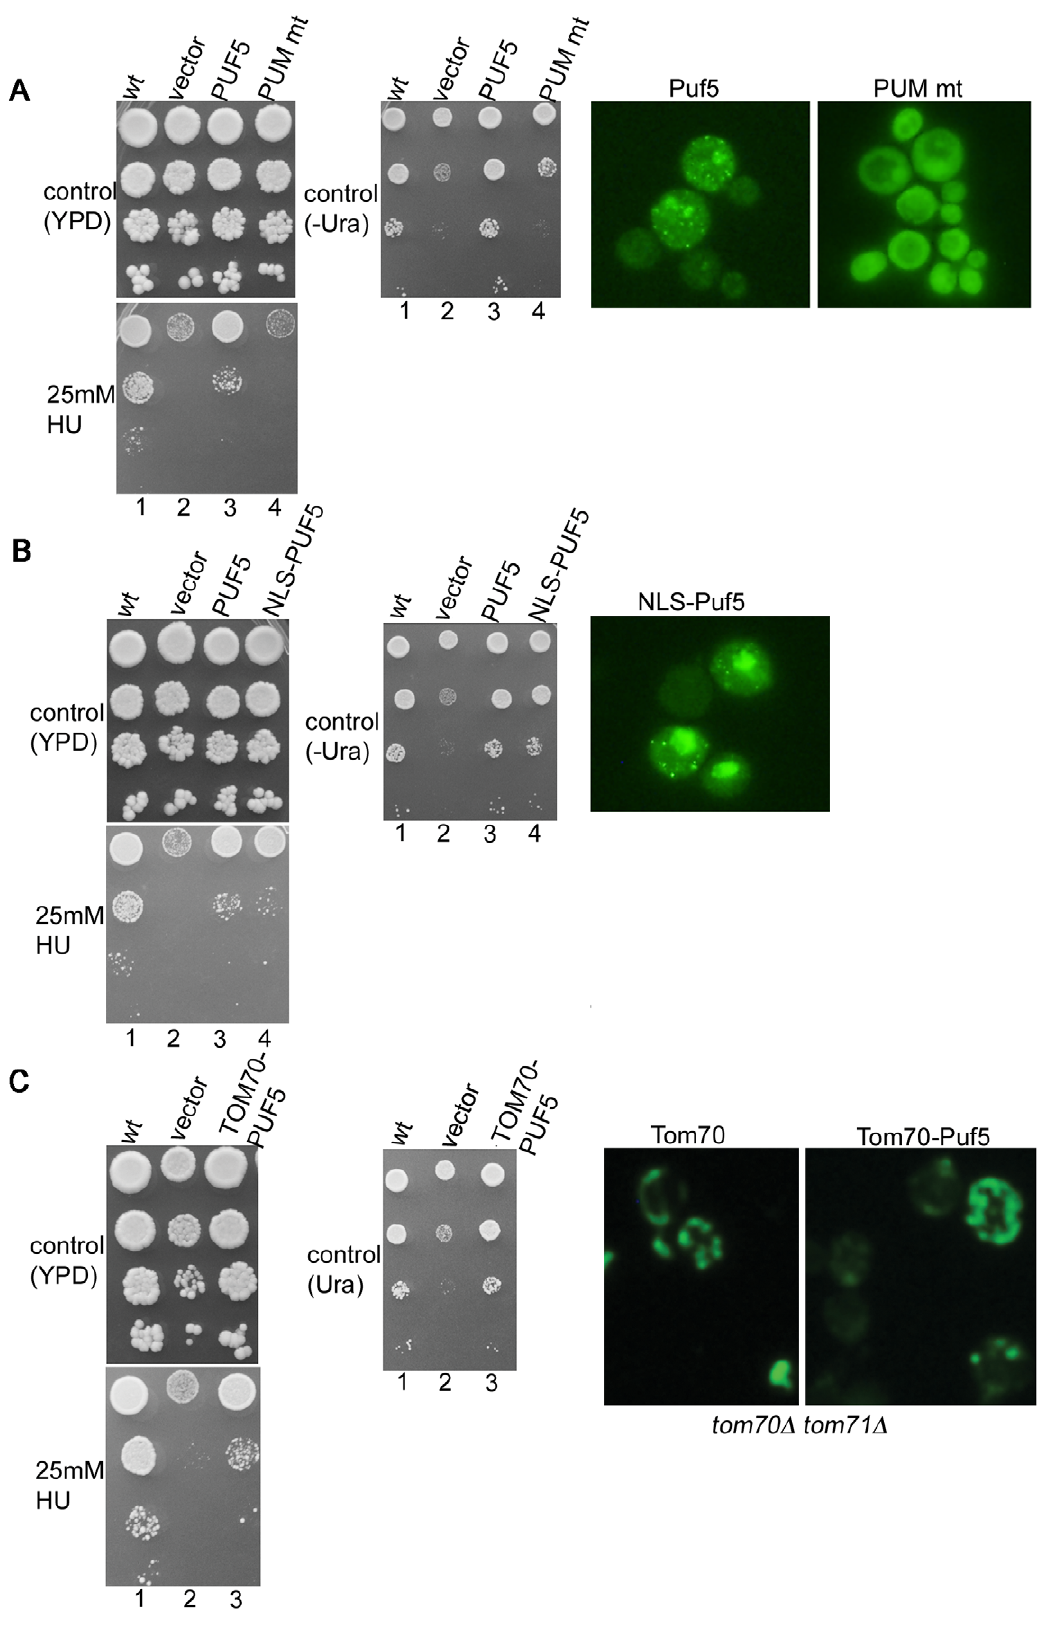
Figure 6. A functional Puf5 RNA binding domain is required and cytoplasmic localization is sufficient for resistance to HU treatment. The experiments were performed in the W3031-A background, in which deletion of PUF5 alone leads to a strong HU sensitivity